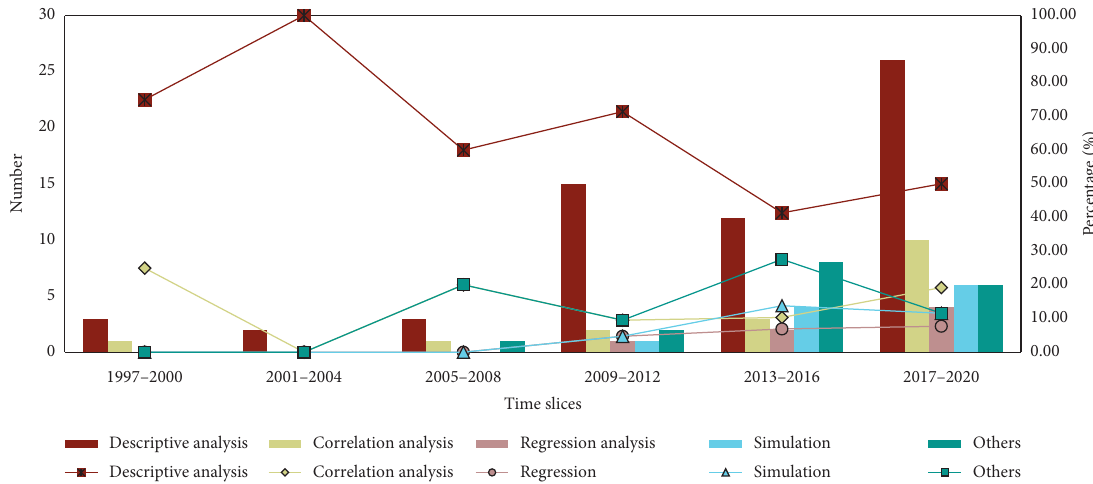
Figure 7: Trends in quantitative analysis methods across years (1997–2020). Table 9: Distribution of publications by quantitative analysis methods and categories of network